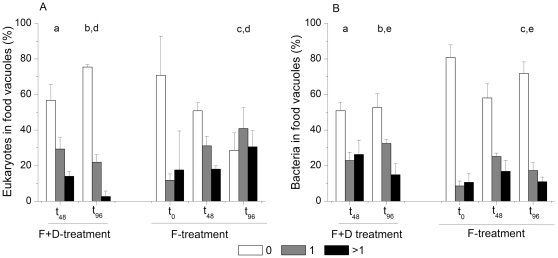
Food preferences of the Cerc_Bal02 in the experiments.Changes in preferred prey of the cercozoan Cerc_Bal02, shown as percentage of the flagellate cells with none, 1 or >1 of eukaryotic or bacterial cells in food vacuoles in (A) the F+D- (5 µm prefiltration and 1∶10 dilution) and (B) F- (5 µm prefiltration) treatments. The data from the t0 timepoint for the F+D-treatment are not available because of low numbers of cells that could be found and analysed. Only significantly different timepoints (p<0.05, χ2-test) are indicated by the corresponding letters.